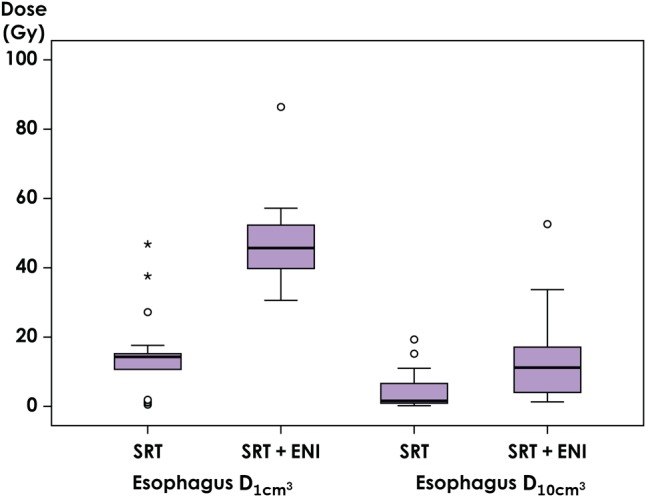
Changes in D1cm3 and D10cm3 of the esophagus. D1cm3 = the minimal radiation doses for the most irradiated volume of 1 cm3, D10cm3 = the minimal radiation doses for the most irradiated volume of 10 cm3, ENI = elective nodal irradiation, SRT = stereotactic body radiotherapy.